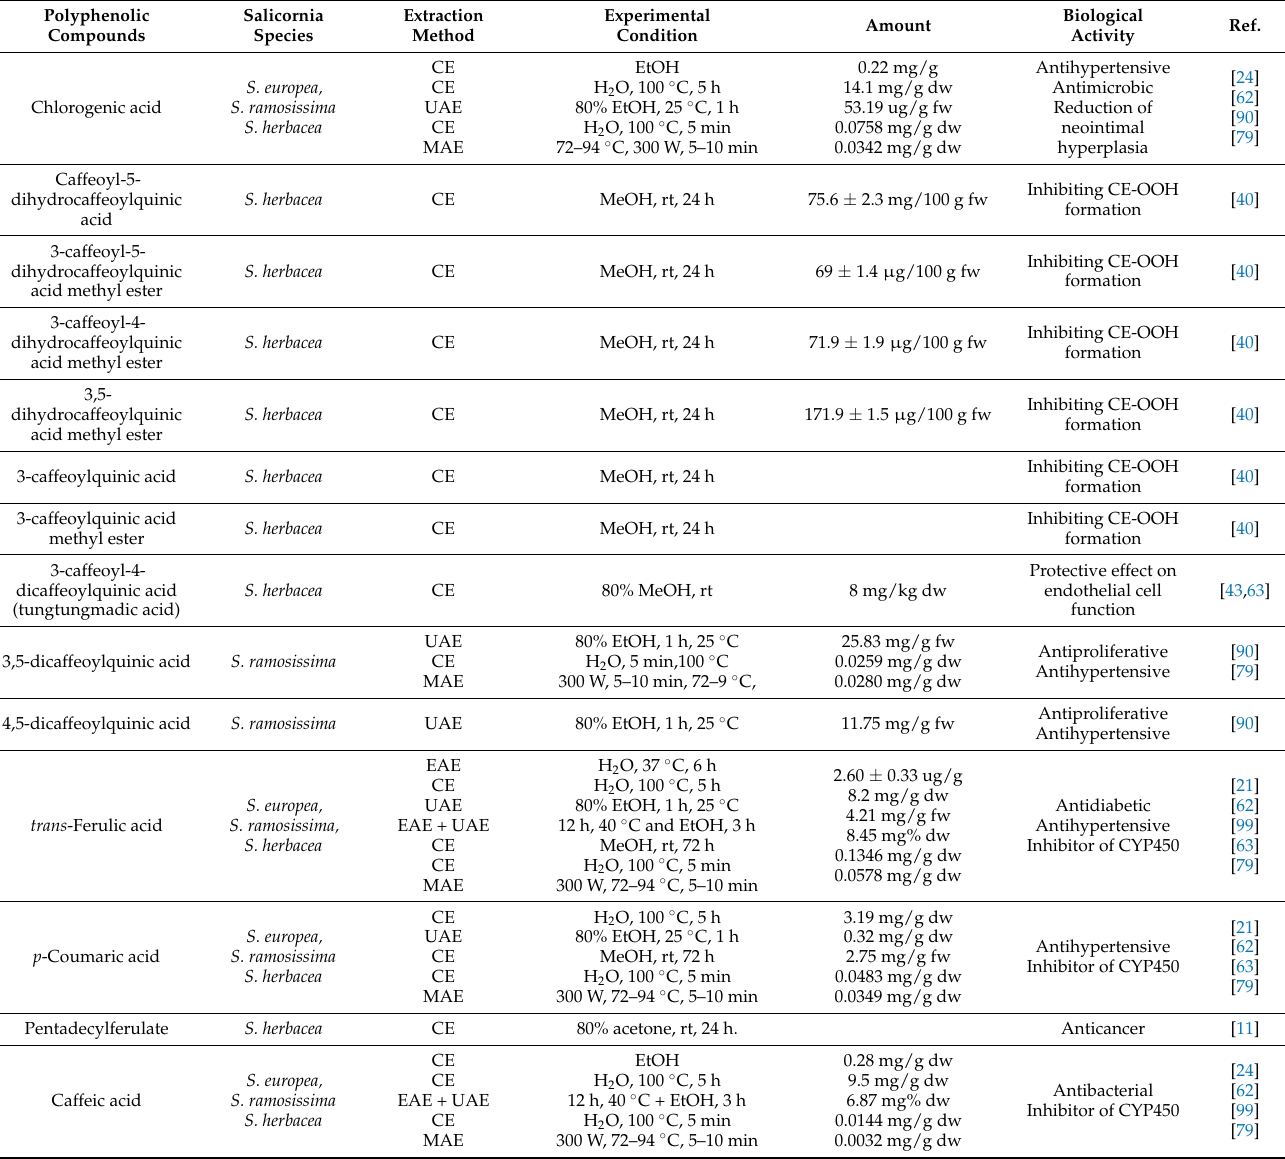
Biological Activity